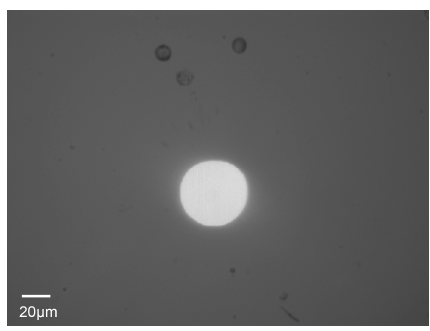
Figure 12. The speed ranged from 53.3 rpm to 55.5 rpm, and the average self-rotational speed in the nine cycles was 54.76 rpm. The motion trajectory of the cell of interest is shown in Figure 13.